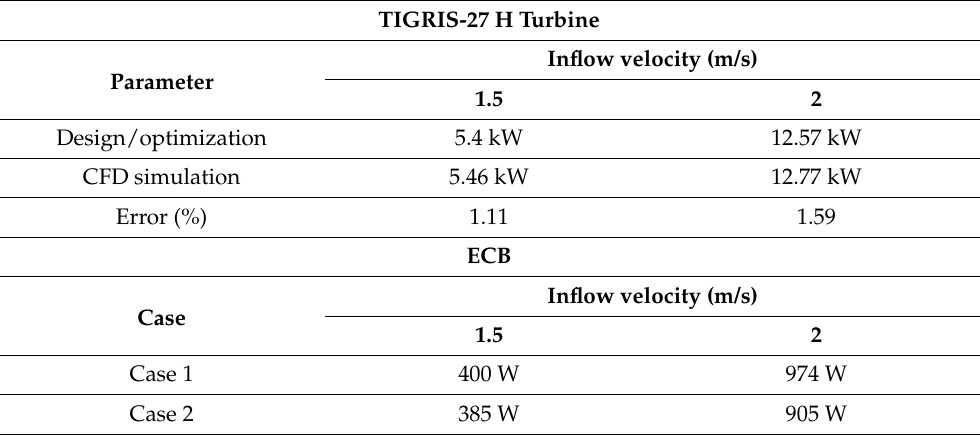
Table 7. Comparison of the Design/optimization and Simulation results of TIGRIS-27 H turbine and